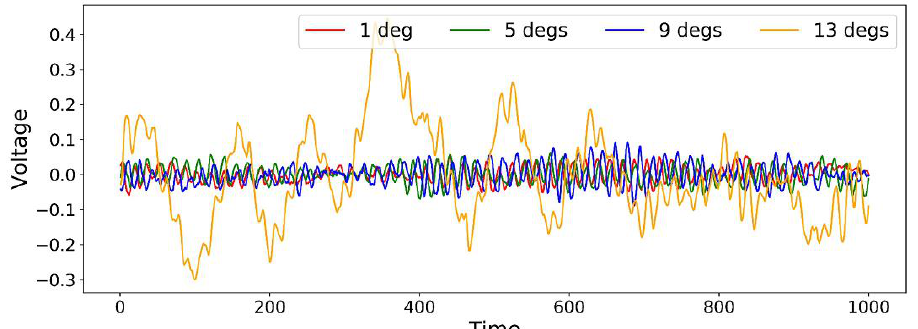
Figure 3. Indicative signals under a set of AoAs and a constant velocity of 10 m/s.